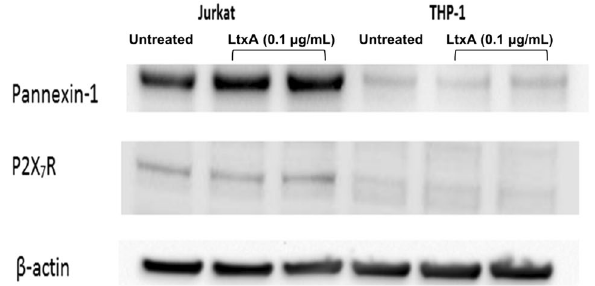
Figure 3. Panx1 and P2X 7 R expression in Jurkat and THP-1 cells. Wild-type Jurkat and THP-1 cells were left untreated or treated with 0.1 µg/mL of LtxA for 1 h. Western blots were performed to determine the expression of Panx1 and P2X 7 R protein content. LtxA treatments are shown in duplicate in lanes 2 and 3 and 5 and 6. β-Actin was used as the loading control. Uncropped gels are presented in Supplementary Figures